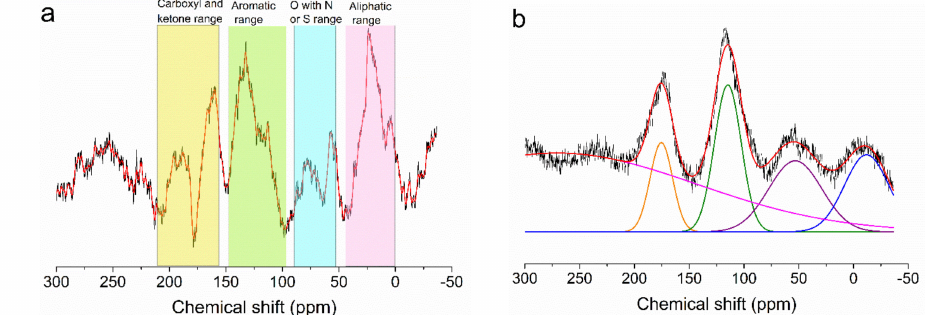
Figure 6. 13 C MAS NMR spectra of the initial acid-char (S13.5) ( a ) and derived activated carbon (S13.5st68) ( b )